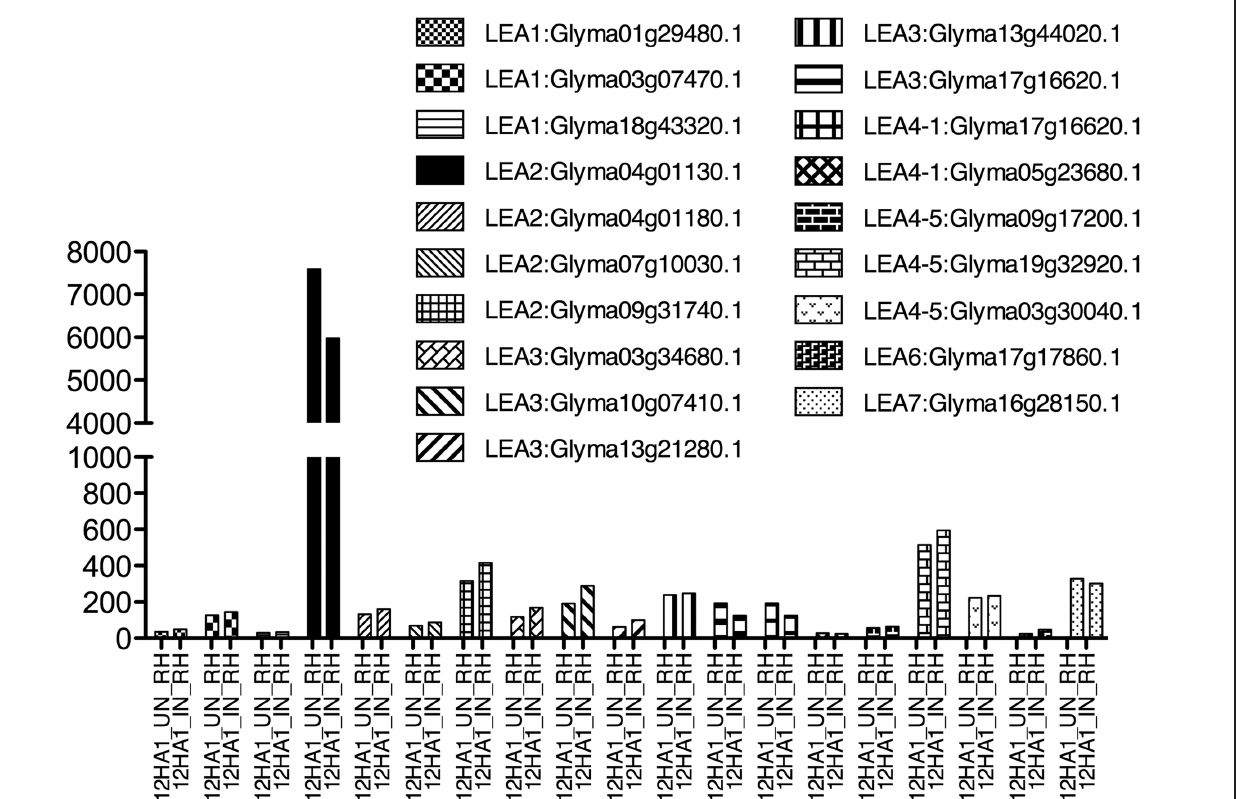
FIGURE 2 | LEA gene expression as detected by Libault et al. (2010a), using Glycine max RNA isolated from un- and infected-root hair cells harvested after 12h inoculation. Infection was done with B. japonicum